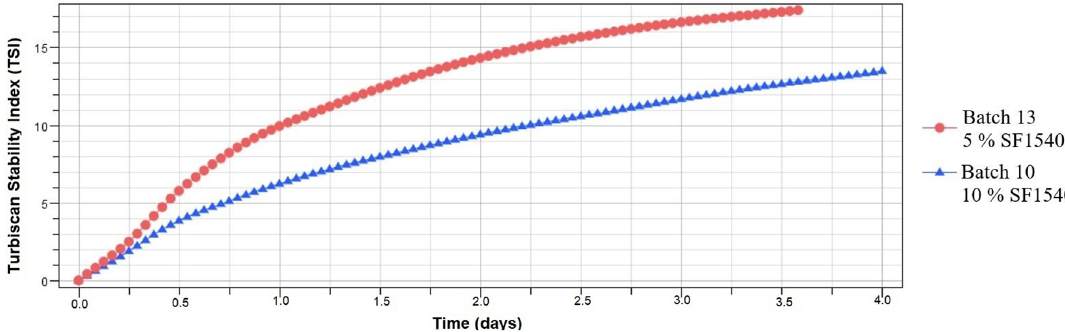
Figure 6. Kinetic stability comparison of Batch 13 and Batch